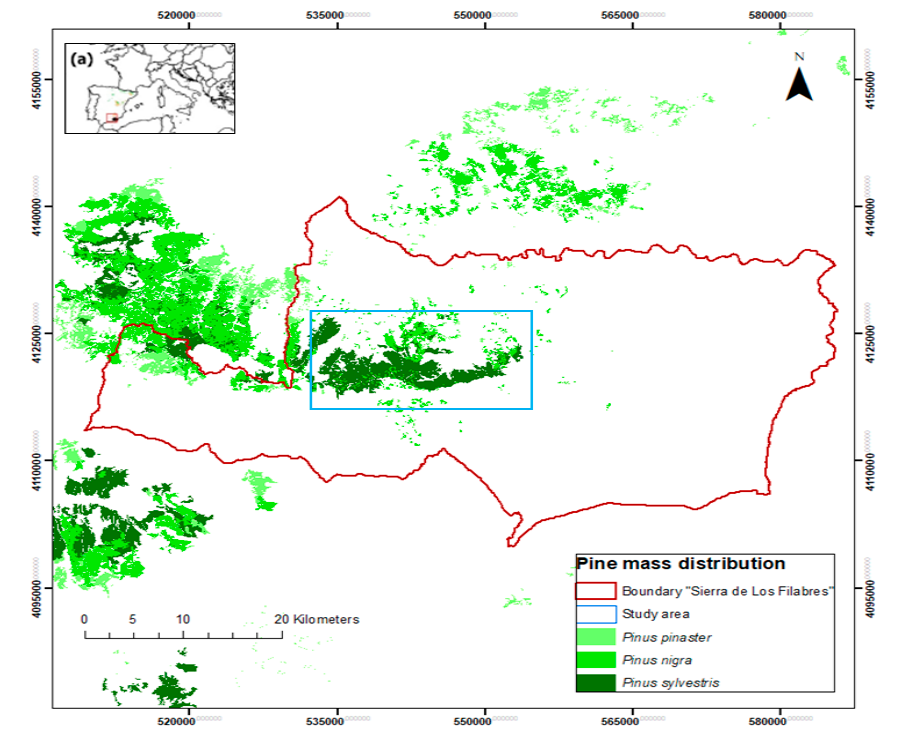
Figure 1. Distribution of Pinus pinaster , Pinus nigra and Pinus sylvestris in the Mediterranean Basin and study area at Sierra de Los Filabres (Almeria, Spain).